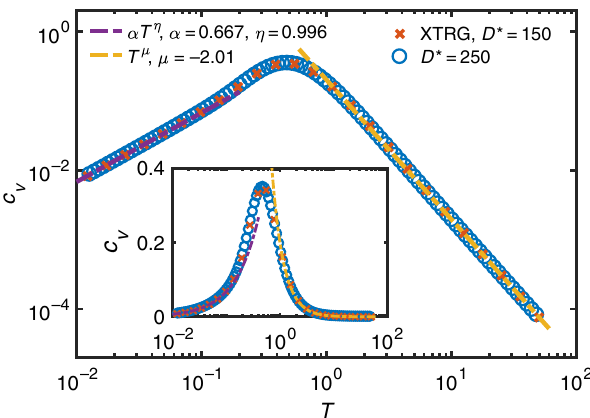
FIG. 6. Specific heat of a Heisenberg chain of length L ¼ 300 , with up to D (cid:3) ¼ 250 multiplets retained. For low temperatures T ≪ 1 , a universal linear behavior versus T is observed, i.e., c α T η with fitted exponent η ¼ 0 . 996 and slope α ≃ 2 = 3 , in the regime T ≤ 0 . 025 . Exploiting the fact that α ¼ ½ð π c Þ = ð 3 v Þ(cid:2) ( v ¼ π = 2 for a spin- 1 = 2 Heisenberg chain), we extract the central charge c ≃ 1 . For large T , the specific heat shows a universal 1 =T 2 temperature dependence (the fit shown is performed for T > 15 ). The inset shows the same data on a linear vertical